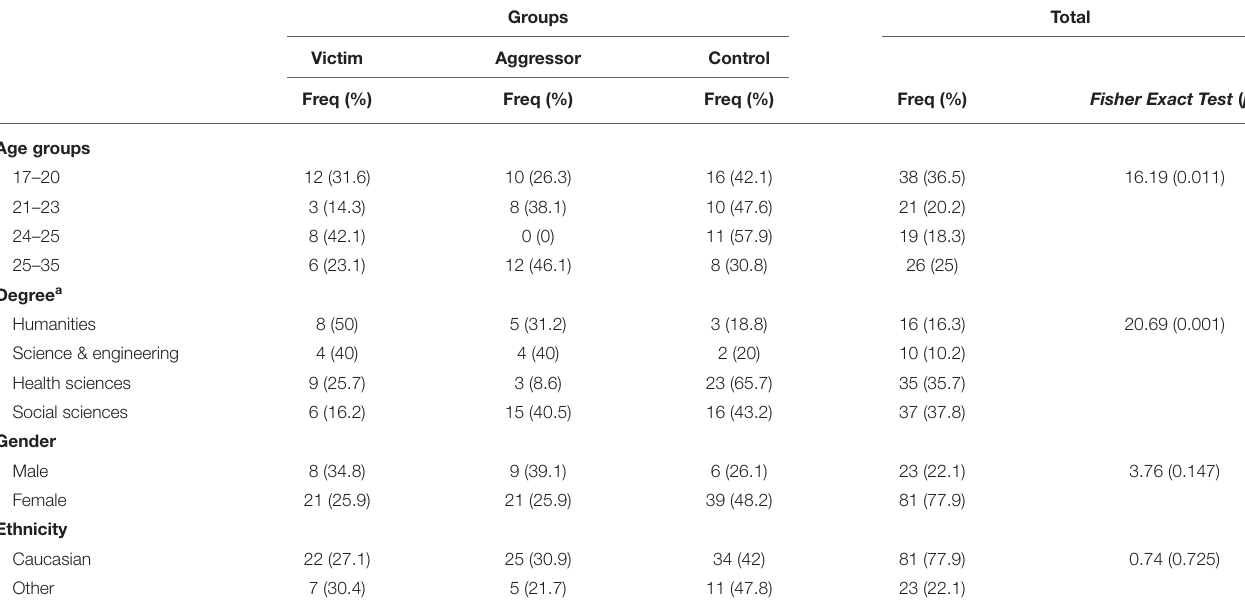
TABLE 1 | Total and percentage of victims, aggressors, and control participants according to age, degree, gender, and ethnicity.